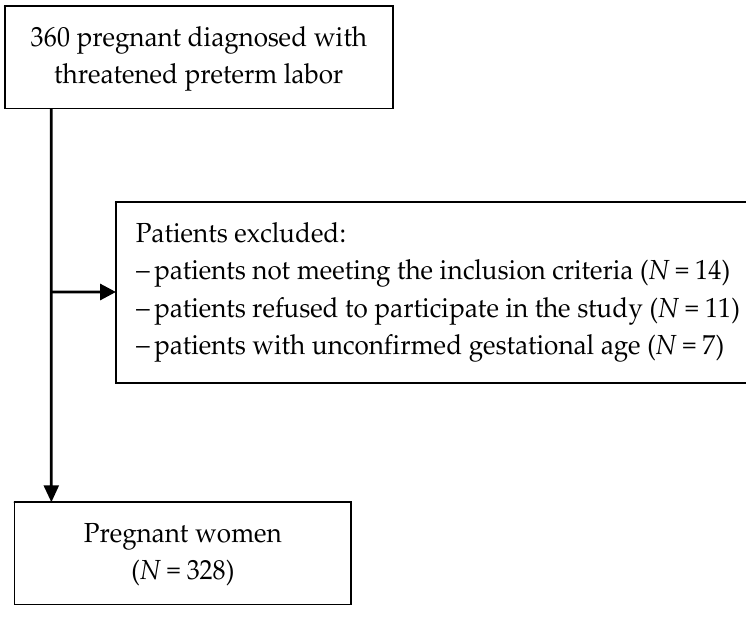
Figure 1. Flowchart of the patient recruitment process.